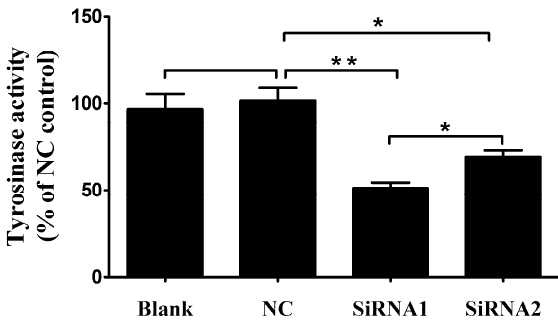
Figure 5. The tyrosinase activity of the control groups and RNA interference groups. The tyrosinase activity was performed with samples from blank group (RNase-free water), NC group (green fluorescent protein (GFP)-siRNA), PpPax3 -siRNA1 group and PpPax3 -siRNA2 group. The tyrosinase activity was shown with percentage of every group and NC. Each bar was a mean of 6 pearl oysters. Significant difference was indicated by * ( P <0.05) and highly significant difference was indicated by ** ( P <0.01).